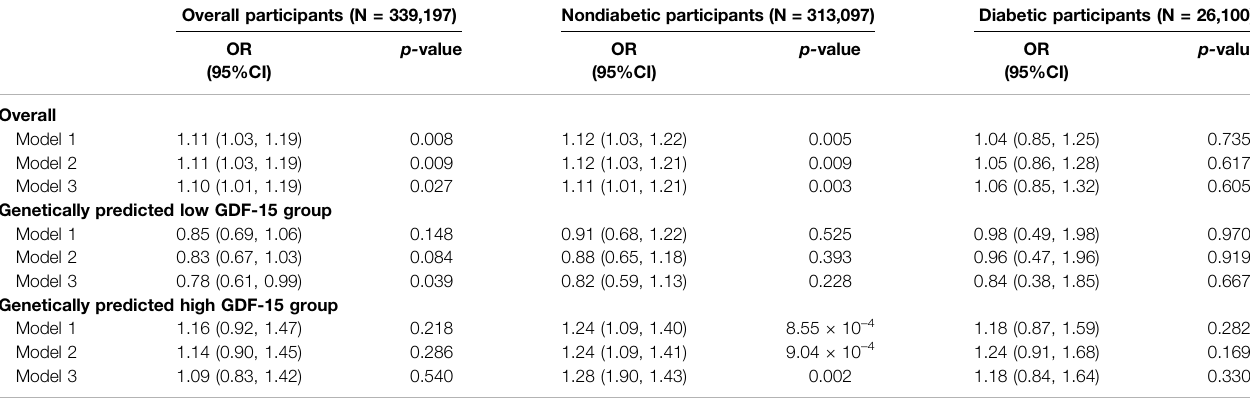
TABLE 4 | Association of genetically predicted growth differentiation factor 15 levels with gallstone disease risk in UK